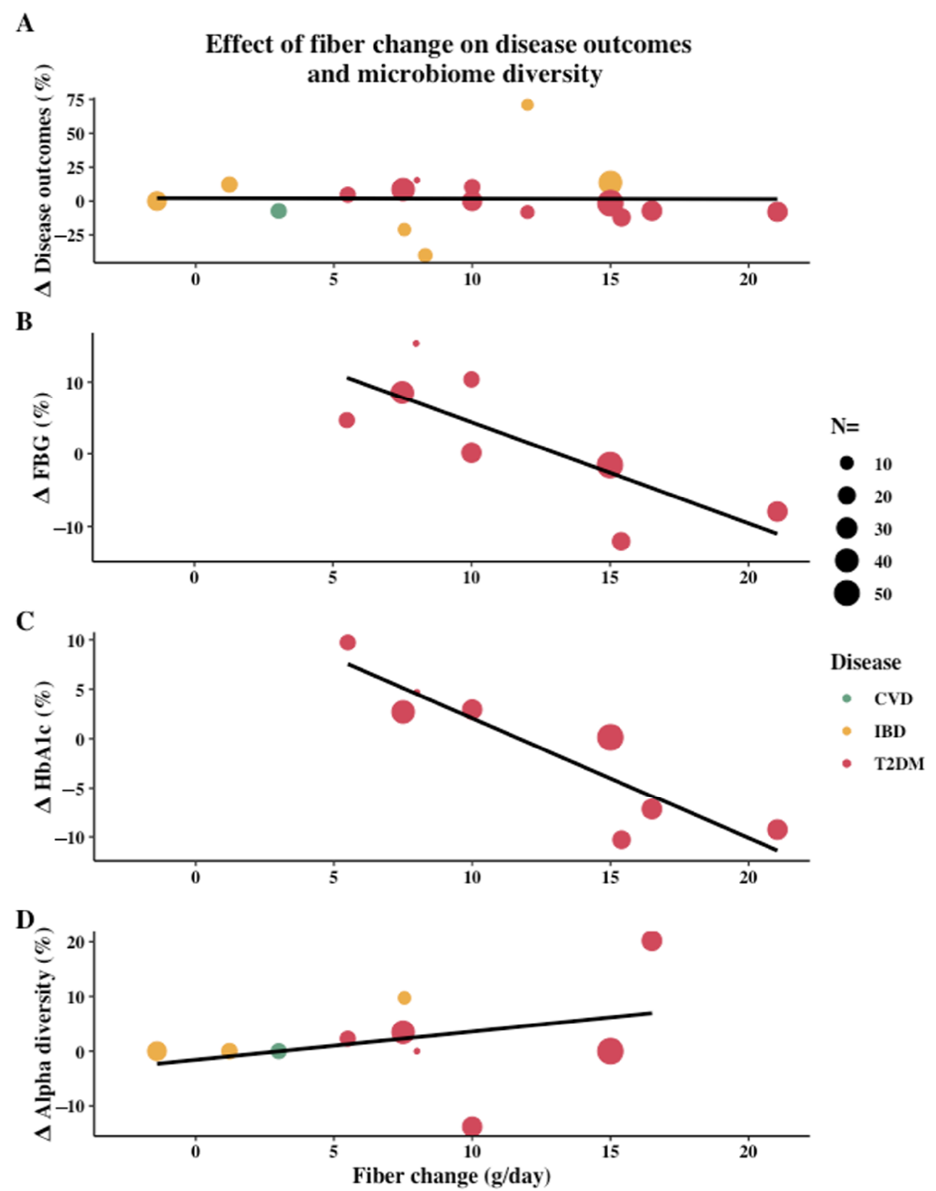
Figure 4. Effect of change in daily fiber intake (g/day) on ( A ) all diseases (type 2 diabetes (T2DM) (red points), inflammatory bowel disease (IBD) (yellow points), and cardiovascular disease (CVD) (green points)) with their respective disease-specific outcomes, ( B ) fasting blood glucose (FBG) in T2DM patients, ( C ) hemoglobin A1c (HbA1c) in T2DM patients, and ( D ) microbiome alpha diversity in all diseases. Percentage relative change between intervention group and control group or end intervention and baseline is used to determine change in disease and microbiome outcomes, as well as fiber change. Only studies which reported the amount of fiber intake were included. Size of the points are based on the number of participants ( n =) in the intervention group. Statistical significance of outcomes not incorporated. In ( D ), changes reported as “non-significant” without numerical results were plotted as a change of